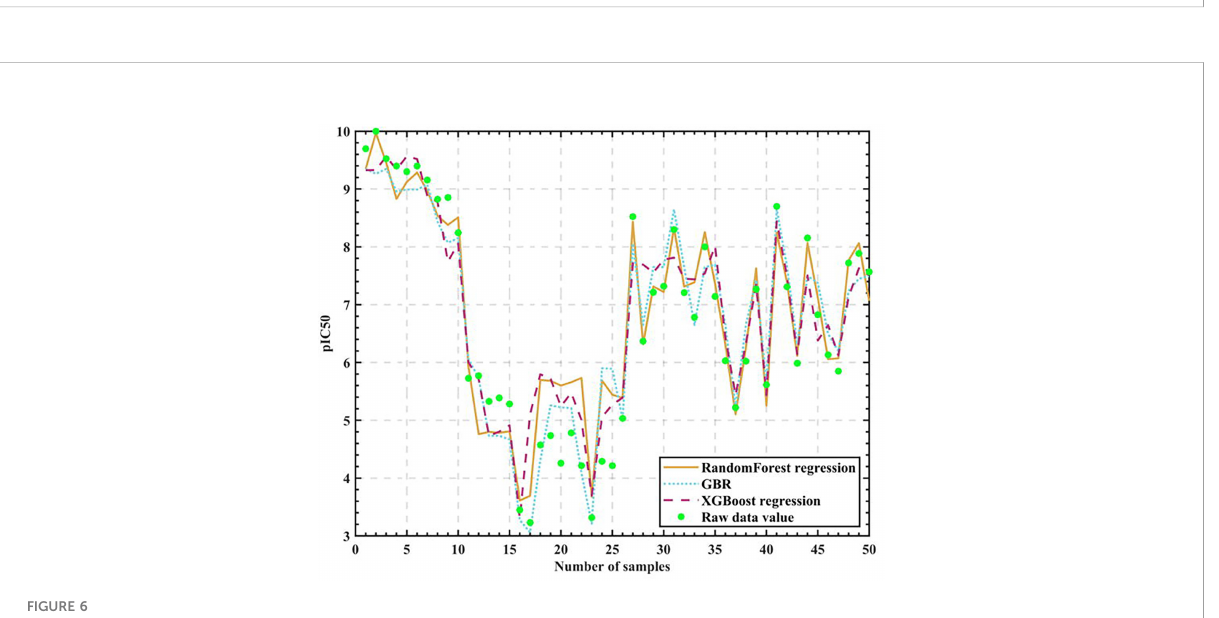
FIGURE 6 Algorithm model test